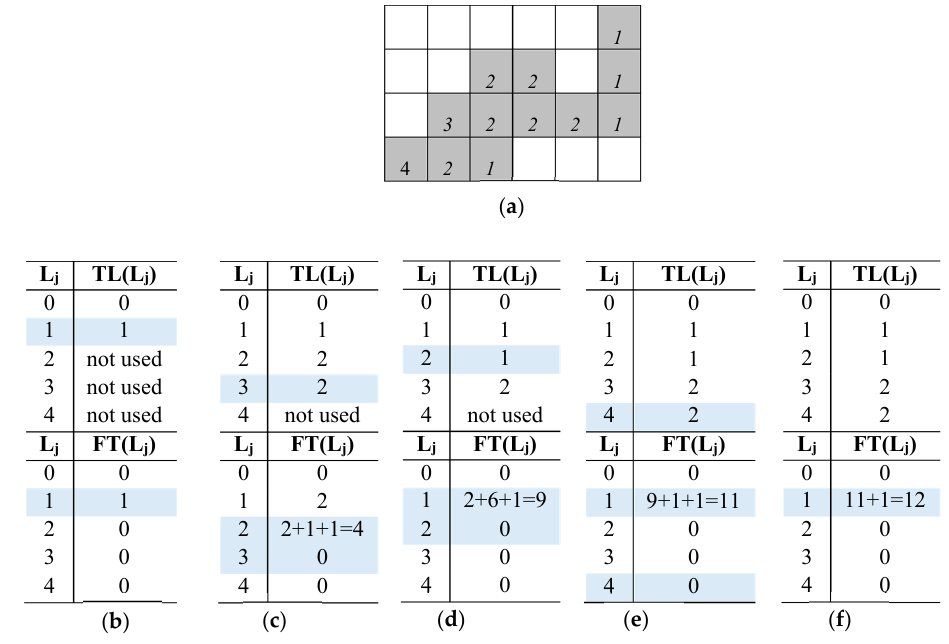
Figure 7. ( a ) The input binary image labeled by the novel algorithm. Status evolution of the Translator LUT and Feature Table ( b – f ).